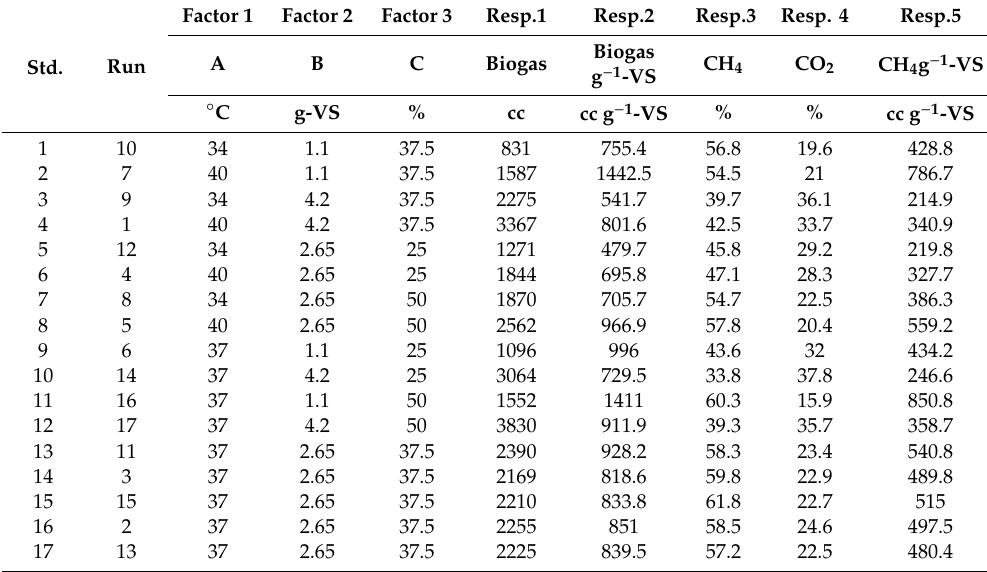
Table 3. The experiment responses results.